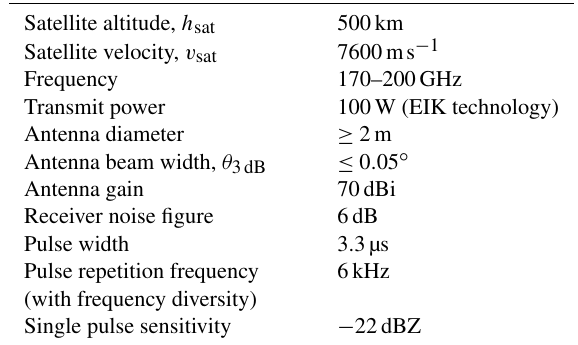
Table 1. Technical specifications of the DAR space-borne system used in this study. The configuration here adopted is the one pro- posed in an on-going UK CEOI study (Duncan Robertson, personal communication,